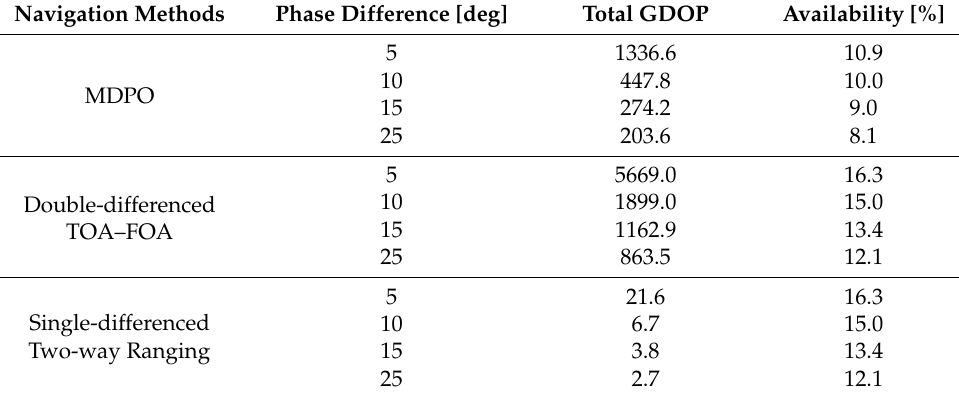
Table 3. The Total GDOP and availability comparison among three navigation methods under different orbital conditions: two satellites were placed in 2100 km circular low lunar orbit with different phase differences (5, 10, 15, and 25 deg). The rover/lander positions were fixed to the south pole ( − 90 deg latitude), and the satellite orbit inclination was fixed to 110